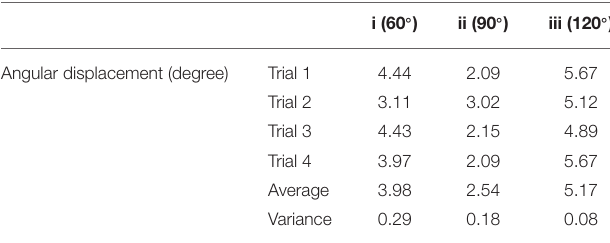
TABLE 2 | Measurement results of angular displacement by applying DC voltage.